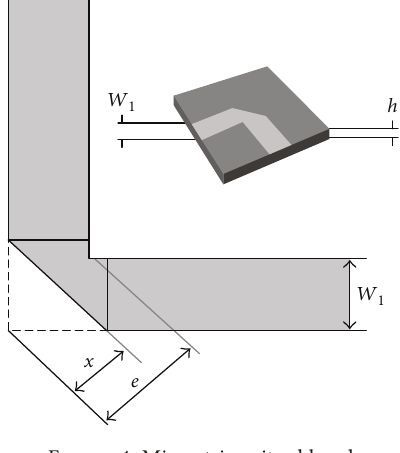
Figure 4: Microstrip mitred